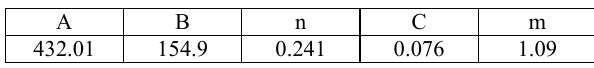
Fig. 7. Johnson-Cook fitting with True stress-strain data. Table 1. ECAPed OFHC-Cu JC Parameters (ref. strain rate: 1/s).